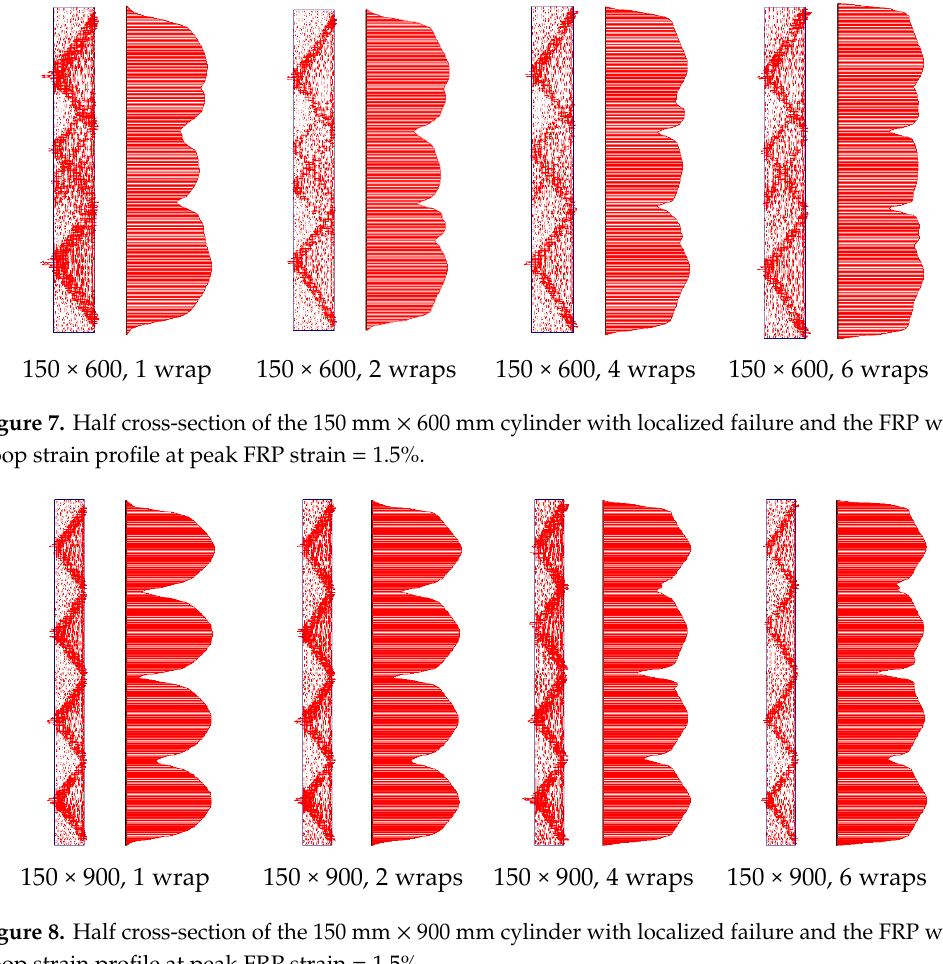
Table 1. Axial and hoop stresses and strains, and the strain ratio.